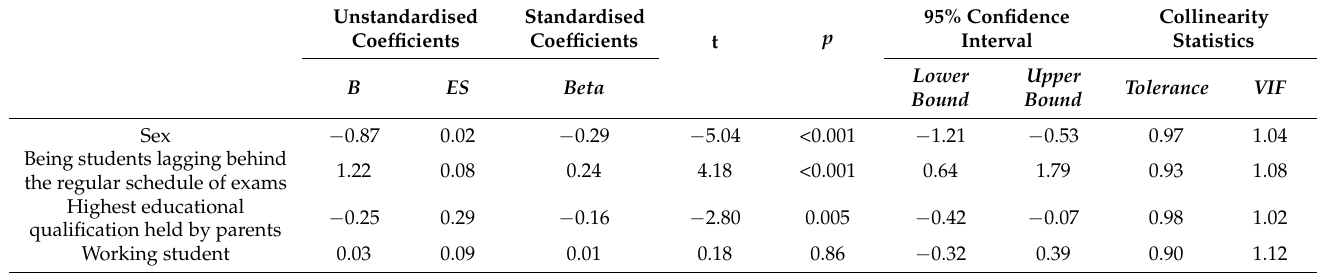
Table 4. Multiple linear regression for the definition of possible predictors of pathological